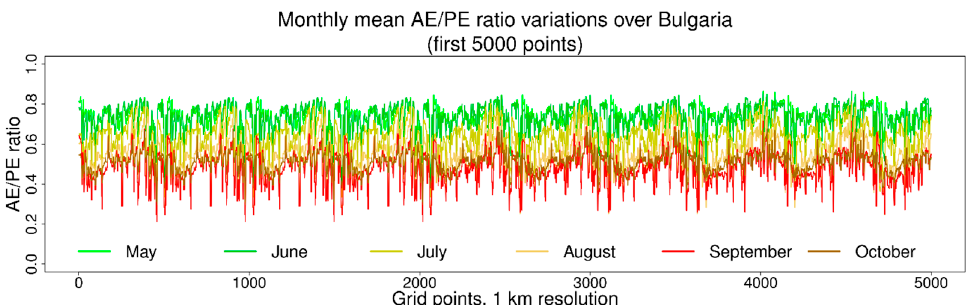
Figure 5. Comparison of monthly (May–October, 2011–2020) mean AE/PE variations for the northwestern Bulgarian landmass for: ( a ) May (bright green); ( b ) June (dark green); ( c ) July (ocher); ( d ) August (orange); ( e ) September (red); ( f ) October (brown). The first 5000 ECMWF grid-point values are used for illustration.